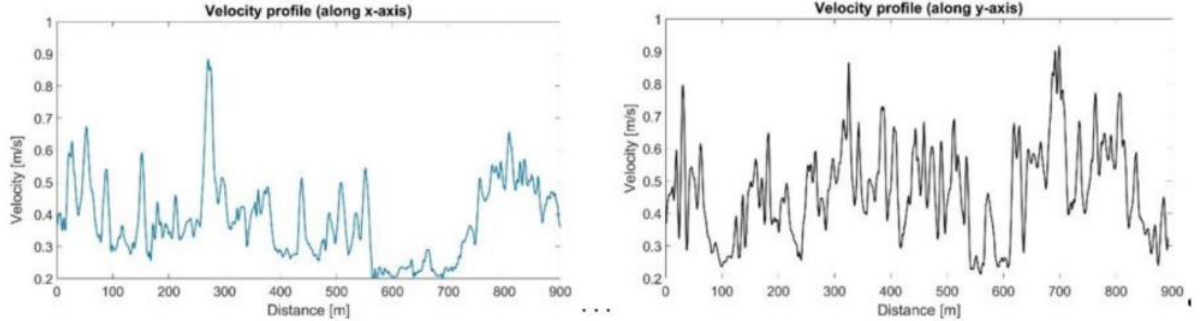
Figure 15. Cross and longitudinal velocity